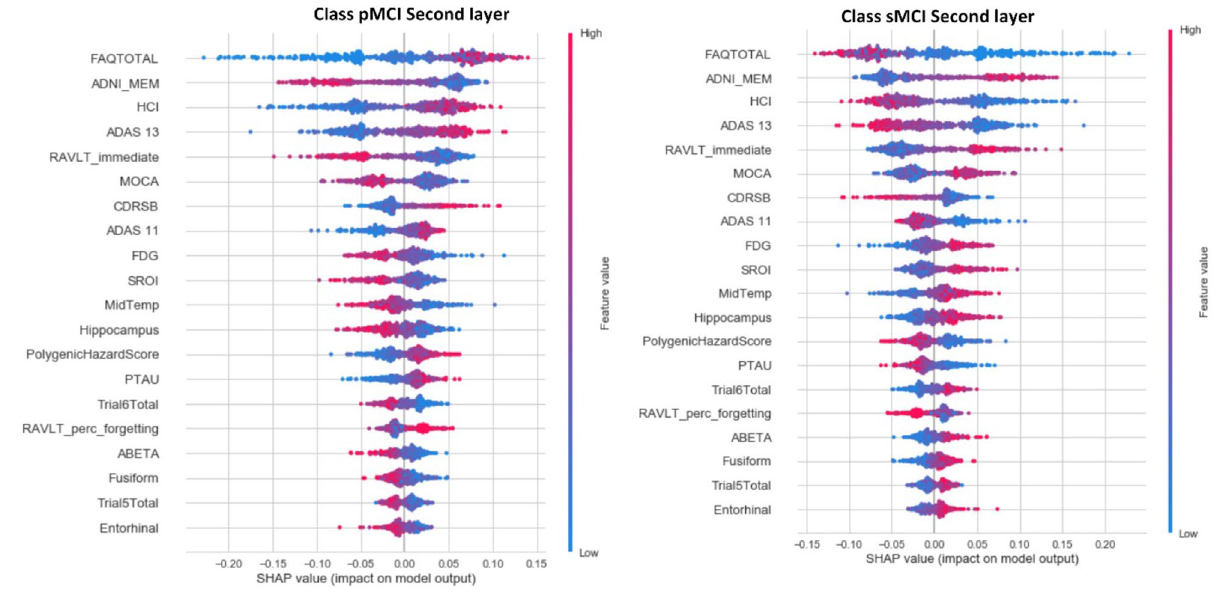
Figure 3. SHAP summary plots for the second layer. The left figure shows the pMCI class, and the right figure shows the sMCI